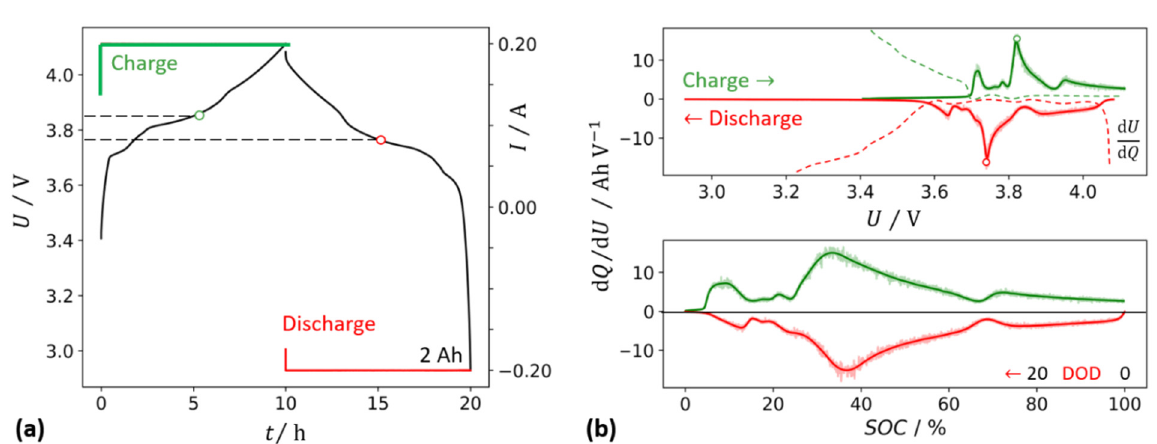
Figure 3. Used Sanyo-Panasonic LCO battery (UR18650F, 2.3 Ah) after cycle test (SOH = 87%). ( a ) Constant current charge–discharge characteristics: U cell voltage, I current. ( b ) Differential capacity d Q /d U and its reciprocal d U/ d Q . Data as measured and smoothed (––). The charge/discharge peak d Q /d U near 3.75 V decreases with aging.